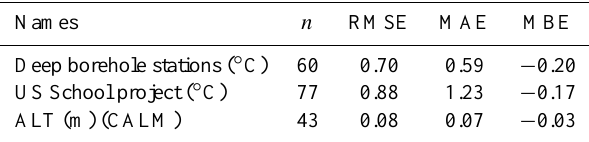
Table 1. The model error statistics obtained by comparing MAGTs and ALTs from 3 different datasets: 60 deep borehole stations com- pared for 2007–2009 years; 77 US School project stations from relatively shallow depths compared for 2009; 43 averaged active layer thicknesses from CALM stations compared over entire avail- able time periods.